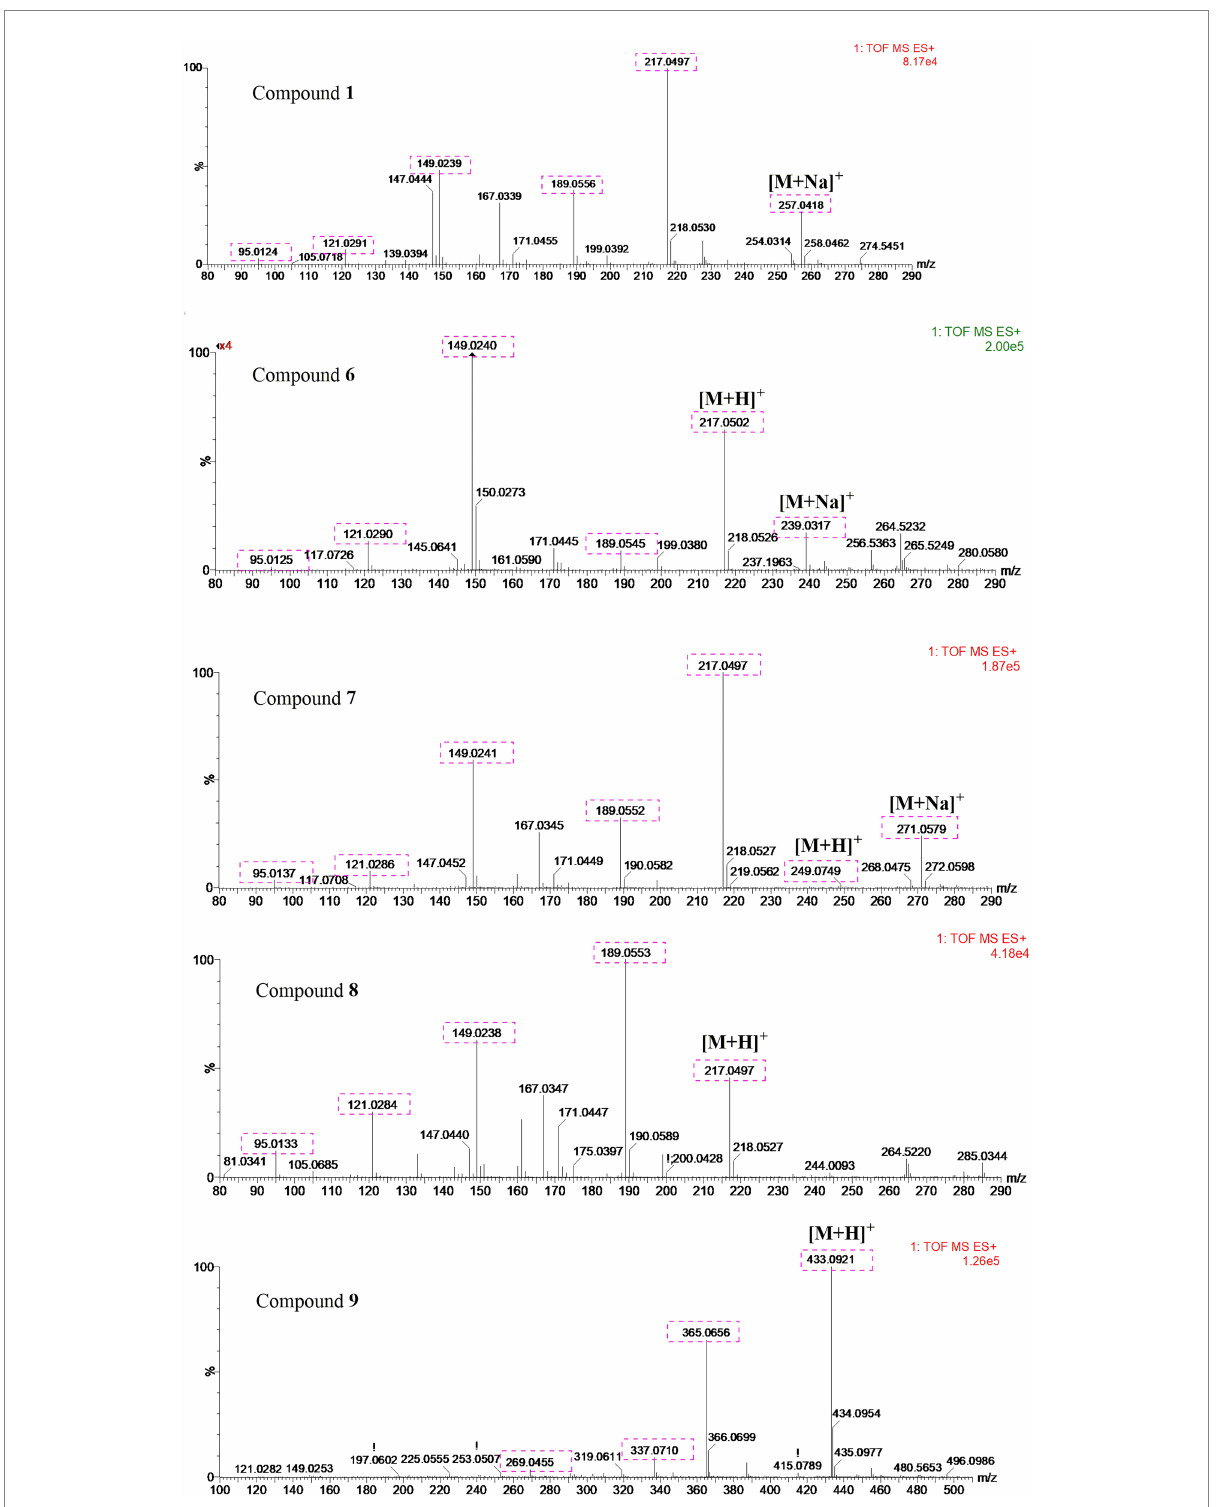
FIGURE 5 The analysis of UPLC-Q-TOF-MS spectra of compounds 1 and 6–9 .